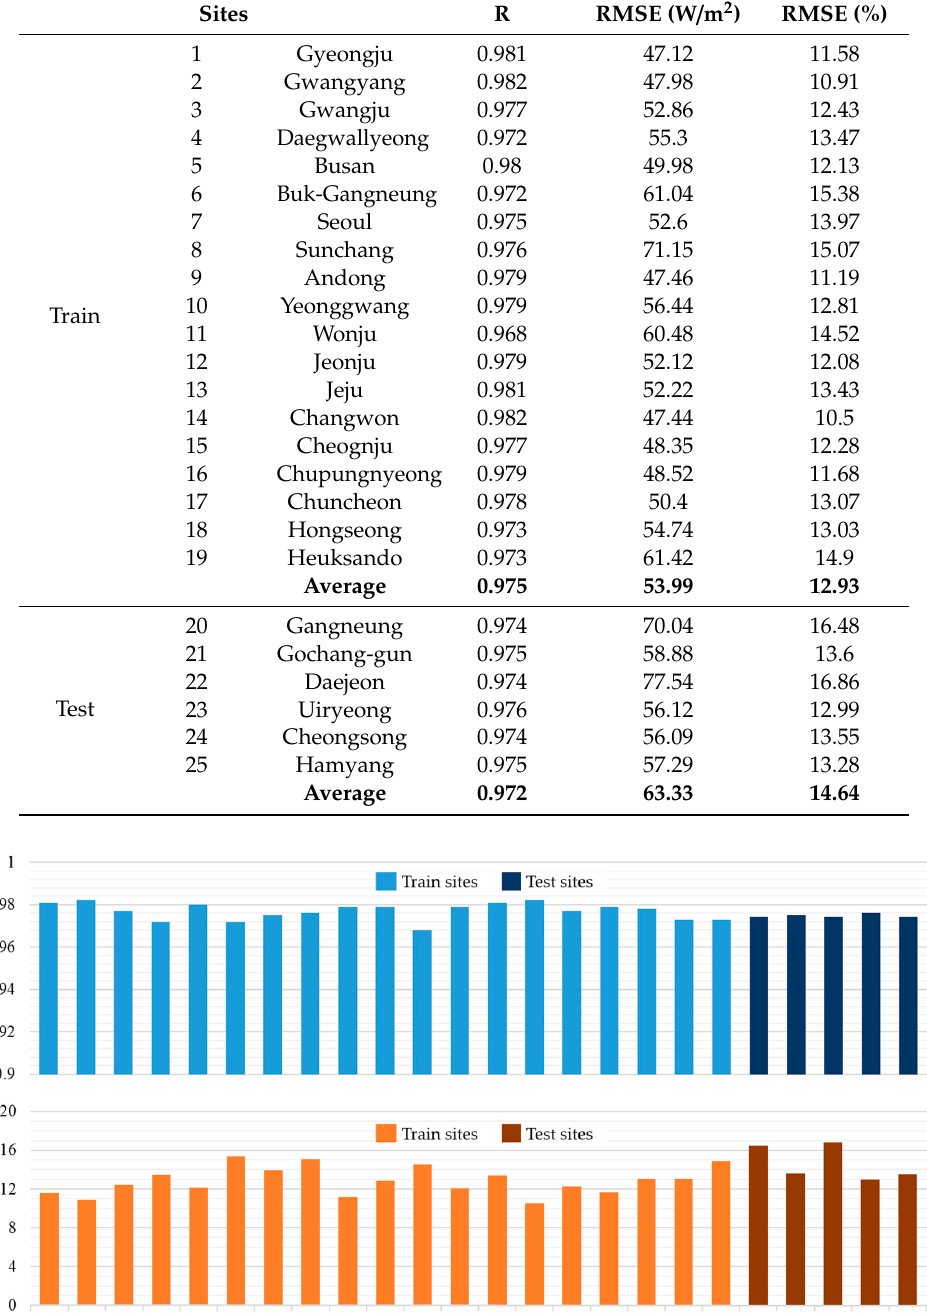
Table 4. Accuracy of the spatial validation of the ANN model for each weather station. Sites